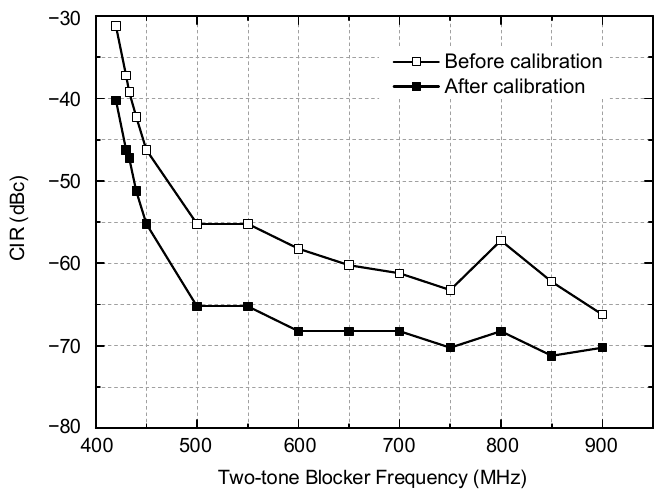
Figure 13. Measured maximum tolerable CIR against two-tone blocker.